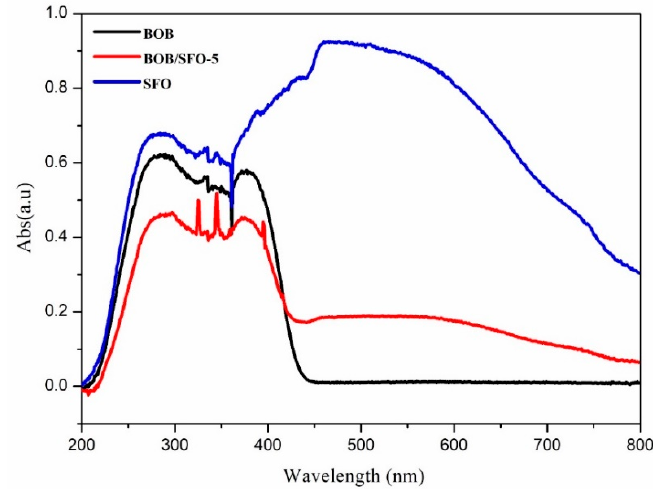
Figure 4. UV-VIS di ff uses reflectance spectra of BOB, SFO, and BOB / SFO-5. Figure 4. UV-VIS diffuses reflectance spectra of BOB, SFO, and BOB/SFO-5.